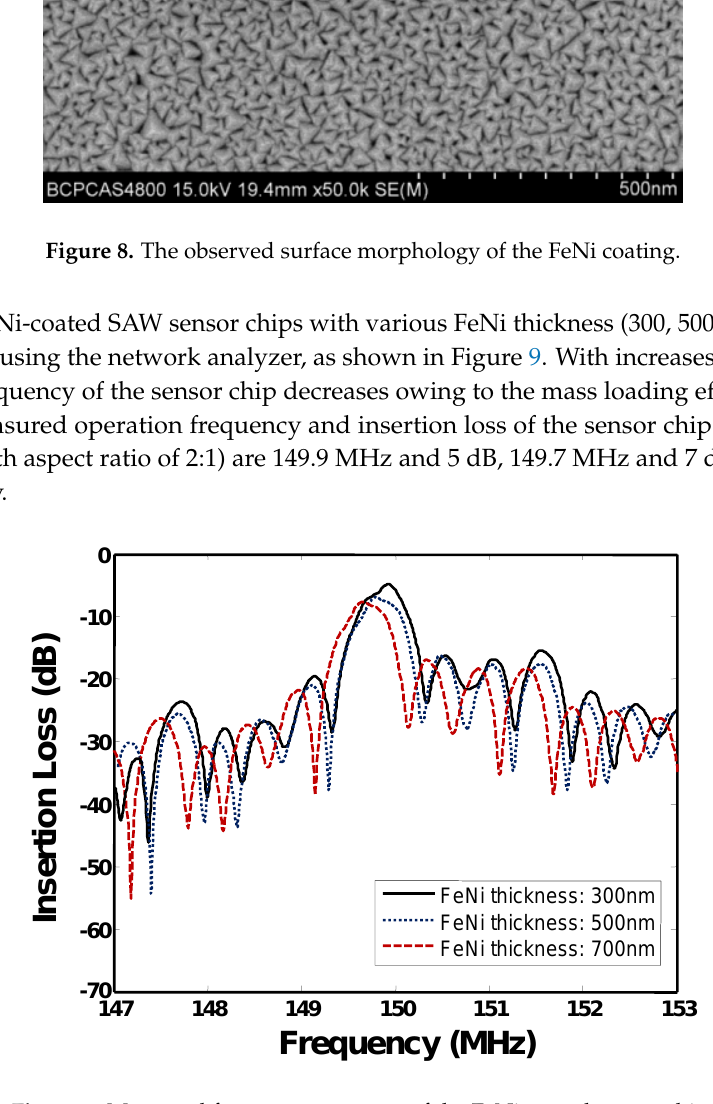
Figure 9. Measured frequency response of the FeNi coated sensor chip.